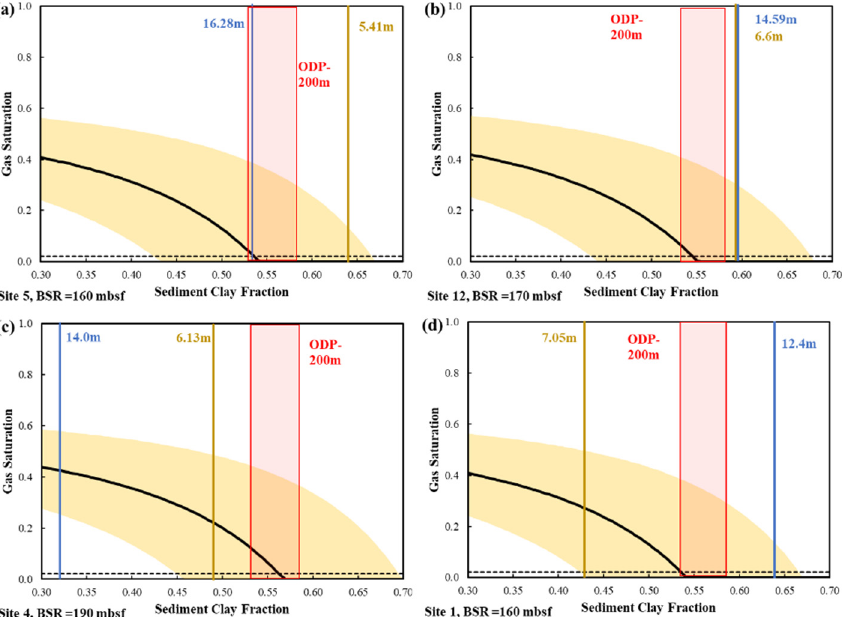
Figure 8. Minimum gas saturation required to open fractures for the 4 sites for varying sediment clay fraction ( f c ). The sites are shown from west to east. Site 5 ( a ) is the westernmost, followed by Site 12 ( b